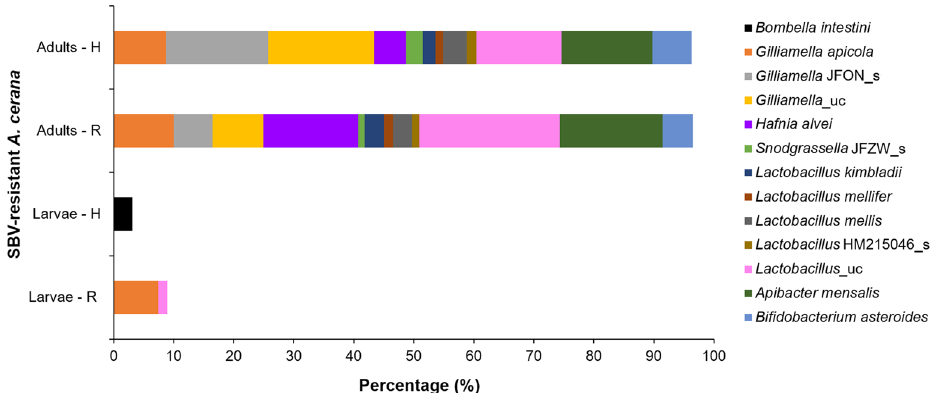
Figure 2. Gut microbiome of SBV-resistant A. cerana . The gut microbiota of adults and larvae of two artificially bred A. cerana strains, R (individual immunity) and H (social immunity), was identified and confirmed to be capable to resist SBV (“uc” indicates unclassified species; “JFON_s” and “JFZW_s” indicate uncultured species of genera Gilliamella and Snodgrassella , respectively; HM215046_s indicates the NCBI accession number of Lactobacillus species).